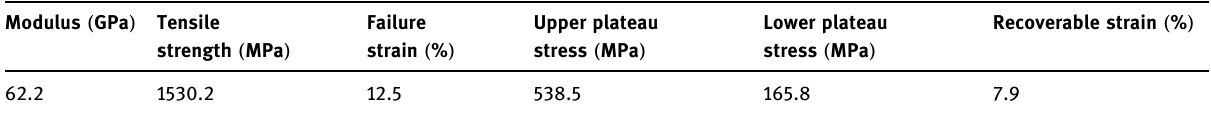
Table 1: The mechanical properties of the SMA fi ber